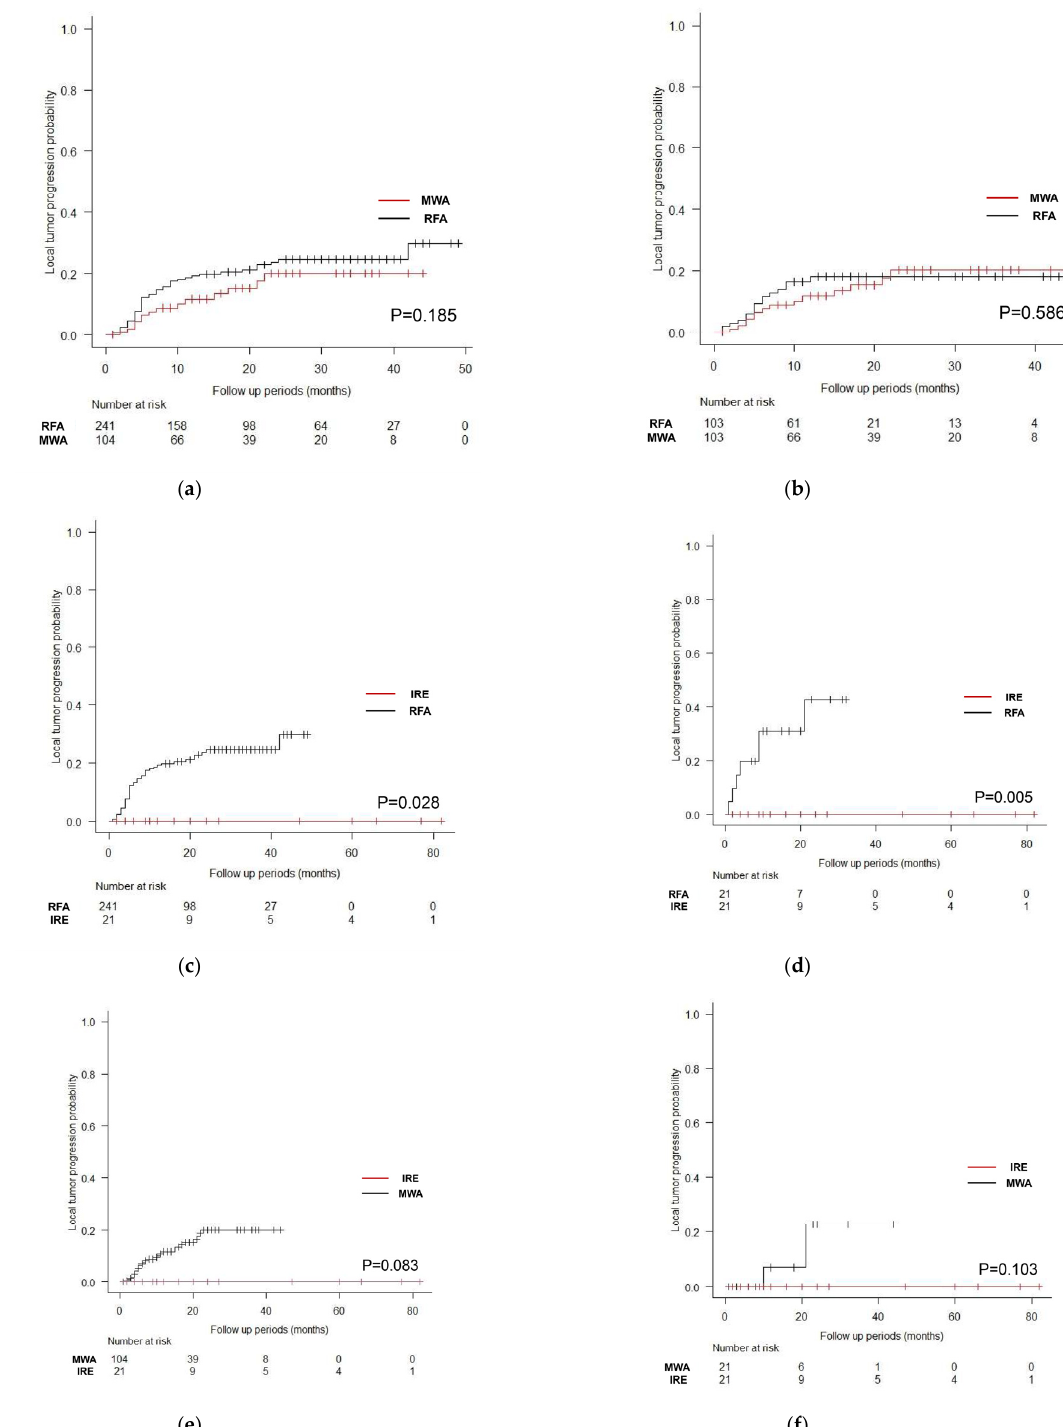
Figure 1. Local tumor progression (LTP) curves with log-rank test stratified by treatment modality with and without propensity score matching. Regarding radiofrequency ablation (RFA) and microwave ablation (MWA), there was no significant difference between cohorts, both with ( a ) (p = 0.185) and without ( b ) ( p = 0.586) propensity score matching. Regarding RFA and irreversible electroporation (IRE), there was a significant difference between cohorts, both with ( c ) ( p = 0.028) and without ( d ) ( p = 0.005) propensity score matching. Regarding MWA and IRE, there was no significant difference between cohorts, both with ( e ) ( p = 0.083) and without ( f ) ( p = 0.103) propensity score